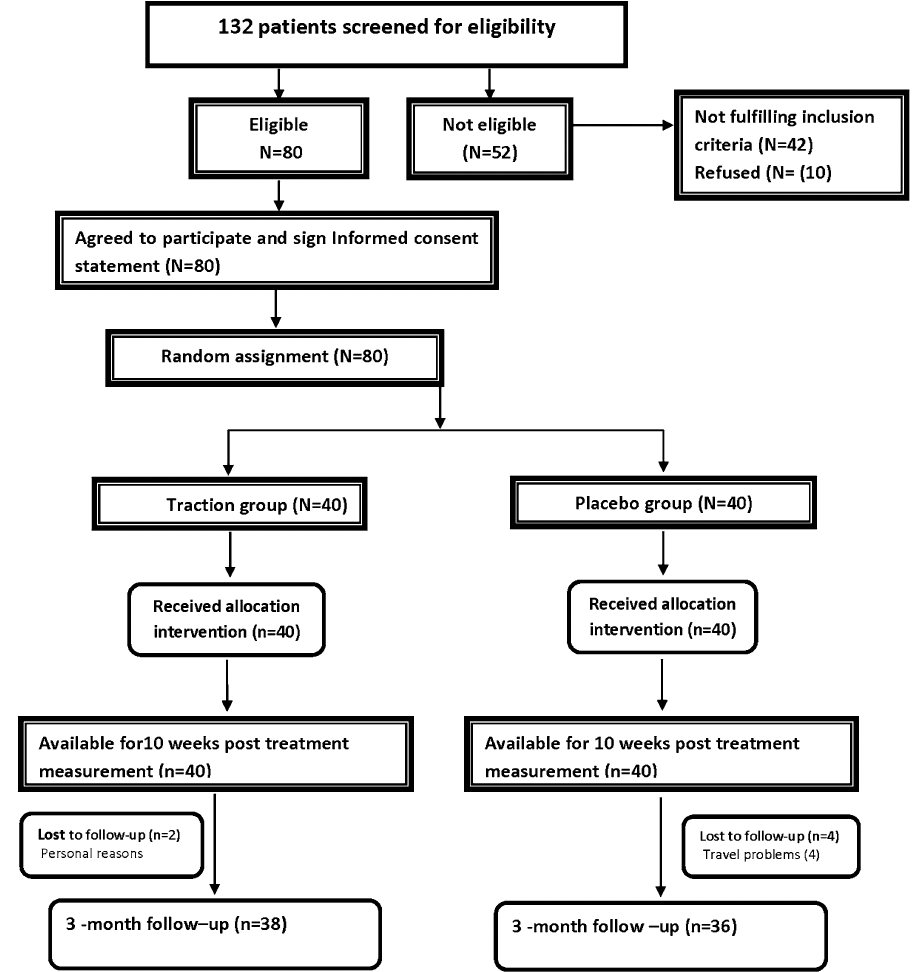
Figure 2. A diagram of patients’ retention and randomization throughout the study.